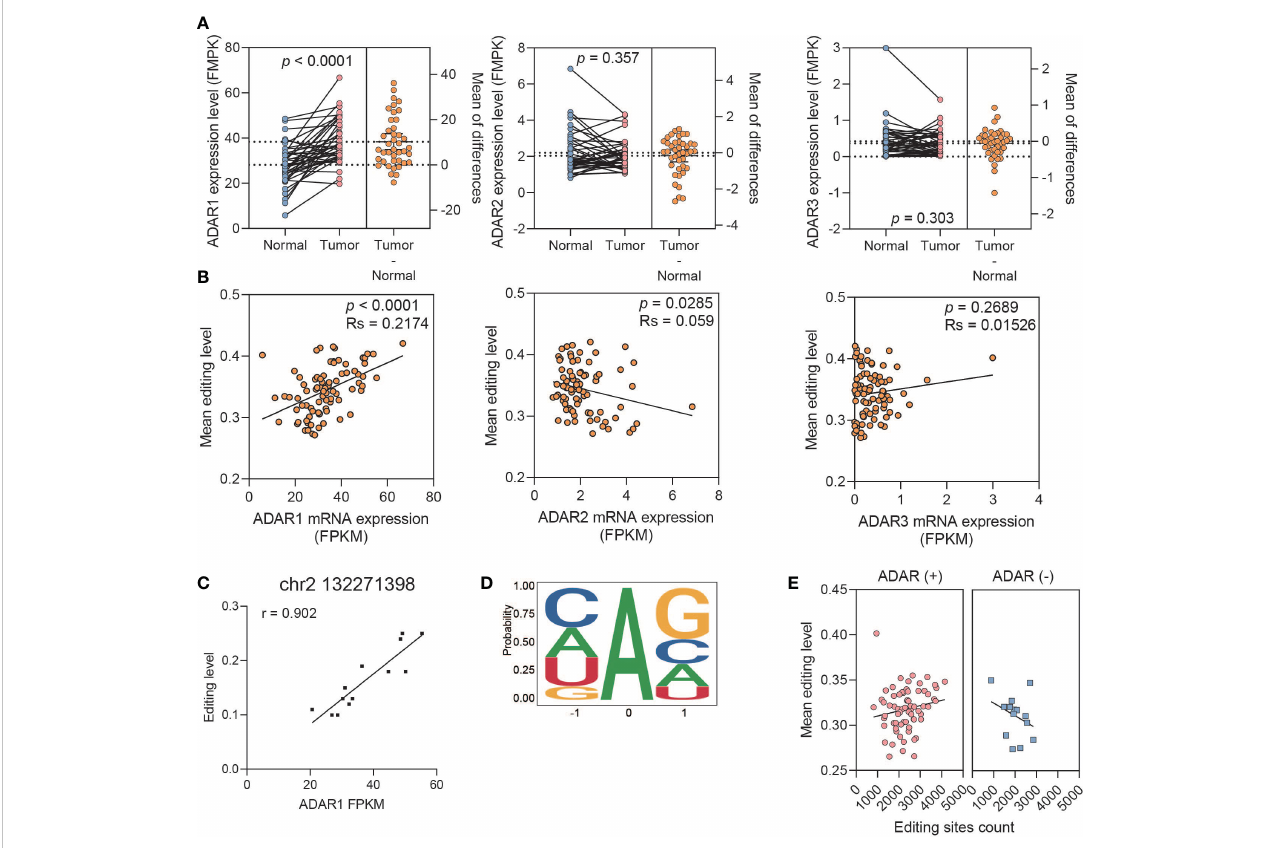
FIGURE 3 ADAR1 regulates A-to-I RNA editing events in PDAC. (A) The relative mRNA expression of ADARs. (B) The correlation between the ADAR expression and mean editing level. (C) A representative editing site, chr2 132271398, shows the high correlation between its editing level and ADAR1 expression. (D) The nucleotide neighboring editing sites show a pattern consistent with known ADAR preference. (E) Boxplots showing a positive correlation between editing level and editing site count upon ADAR1 overexpression samples, and a negative correlation upon ADAR1